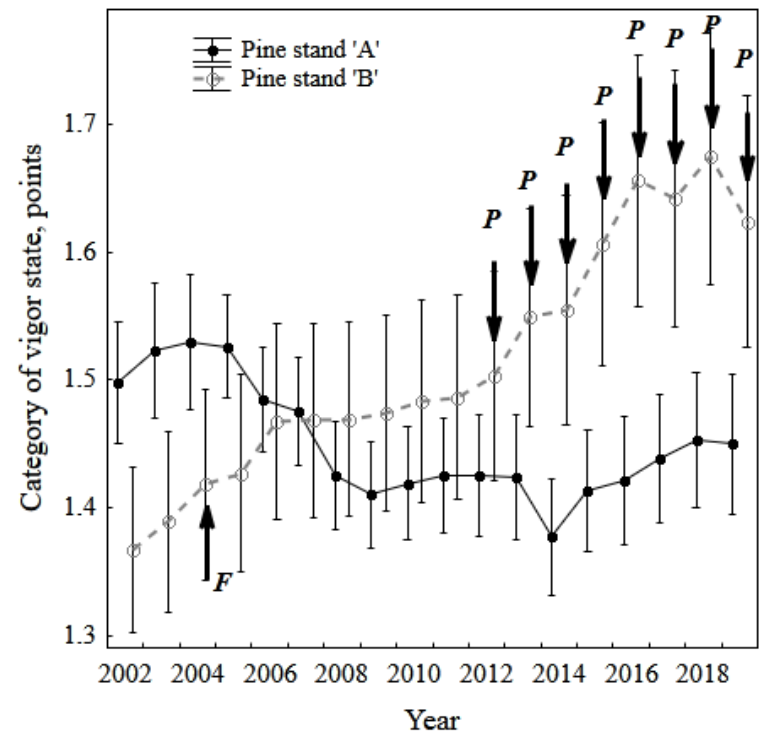
Figure 3. Category of vigor state of pine stands ‘A’ and ‘B’ in permanent sample plots over the years 2002–2019 (an increase in the score of the category corresponds to the deterioration of their condition). Acute or chronic impacts on the stands were caused by a thermal factor ( F , a creeping fire) or chemical factor ( P , pollutants), respectively. Average values for 300–400 trees and their standard errors are